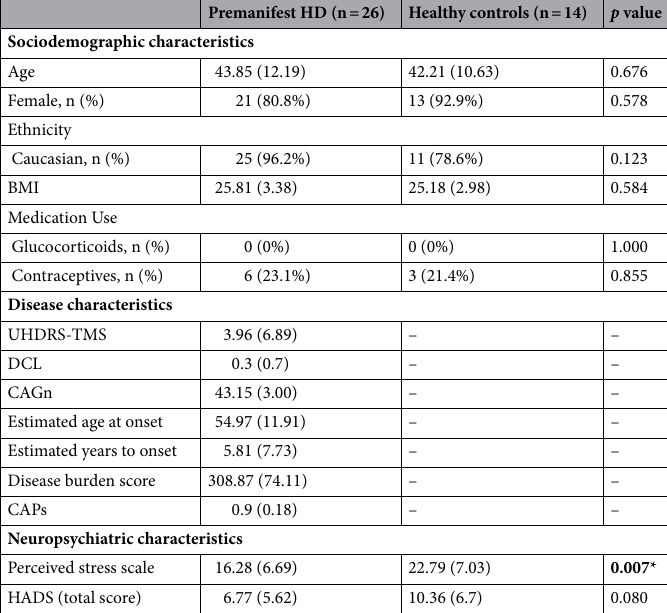
Table 1. Demographic and clinical information for individuals with premanifest HD and healthy controls. Data is reported as mean (standard deviation) unless otherwise stated. T-tests and chi-squared tests were used for comparisons between groups. Results were considered significant at p < 0.05* (bolded values). BMI body mass index, UHDRS-TMS unified Huntington’s disease rating scale total motor score, DCL